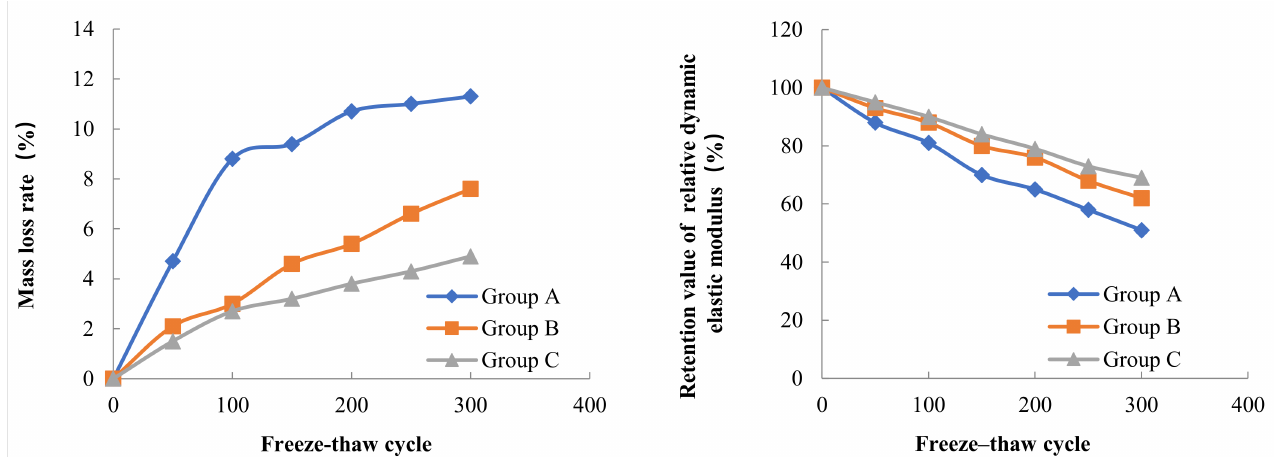
Figure 3. Frost resistance of concrete with different internal humidity ( − 30 ◦ C freezing